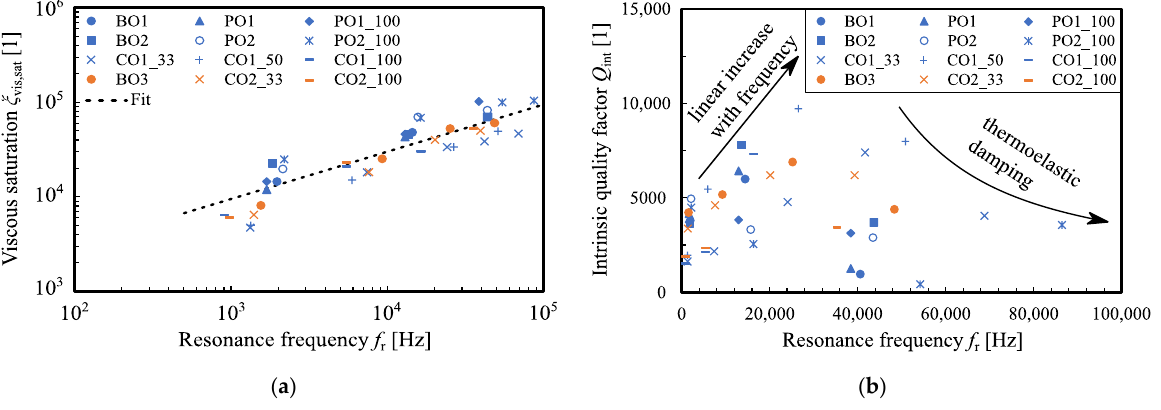
Figure 9. Viscous saturation values for large gaps of all investigated MEMS oscillators as a function of resonance frequency ( a ). The plotted fit line shows the dependence of the quality factor on the frequency in the viscous flow regime according to Equation (8). In ( b ), the intrinsic quality factors of all MEMS oscillators as well as all determined bending modes measured in the high vacuum range at a pressure level of 0.001 mbar are shown.